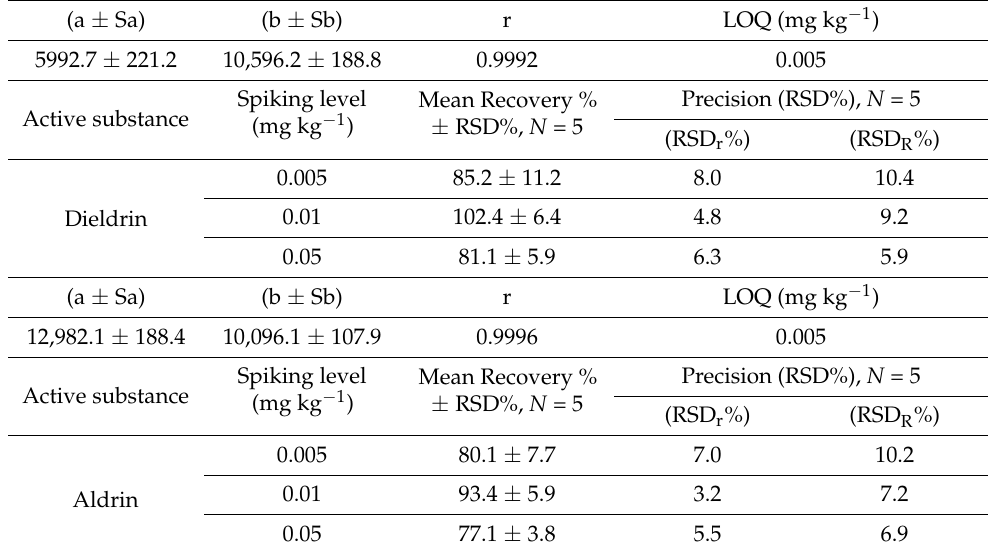
Table 1. Regression parameters, LOQ, recovery, and precision for dieldrin and aldrin in soil